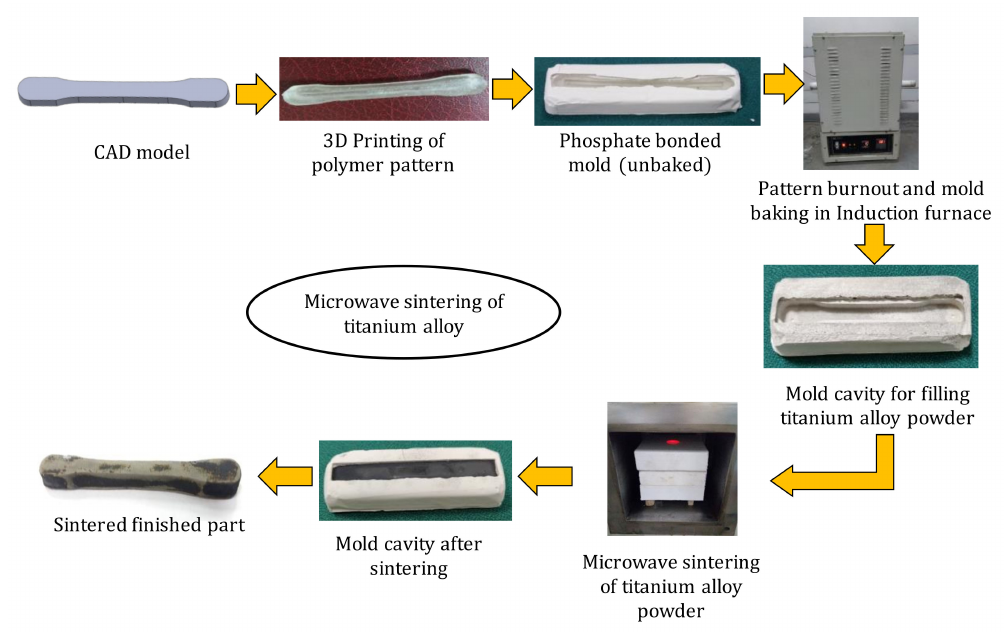
Figure 1. Process flow diagram for the microwave sintering of the titanium